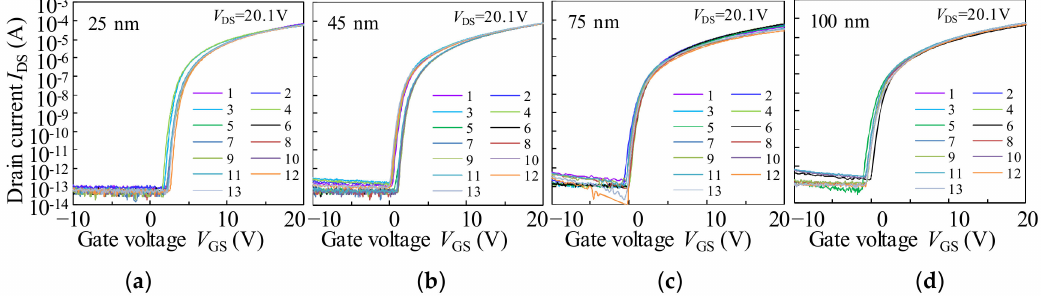
Figure 5. The I DS – V GS of 13 individual TFTs with various T IGZO of ( a ) 25 nm; ( b ) 45 nm; ( c ) 75 nm; and ( d ) 100 nm measured at V DS of 20.1,